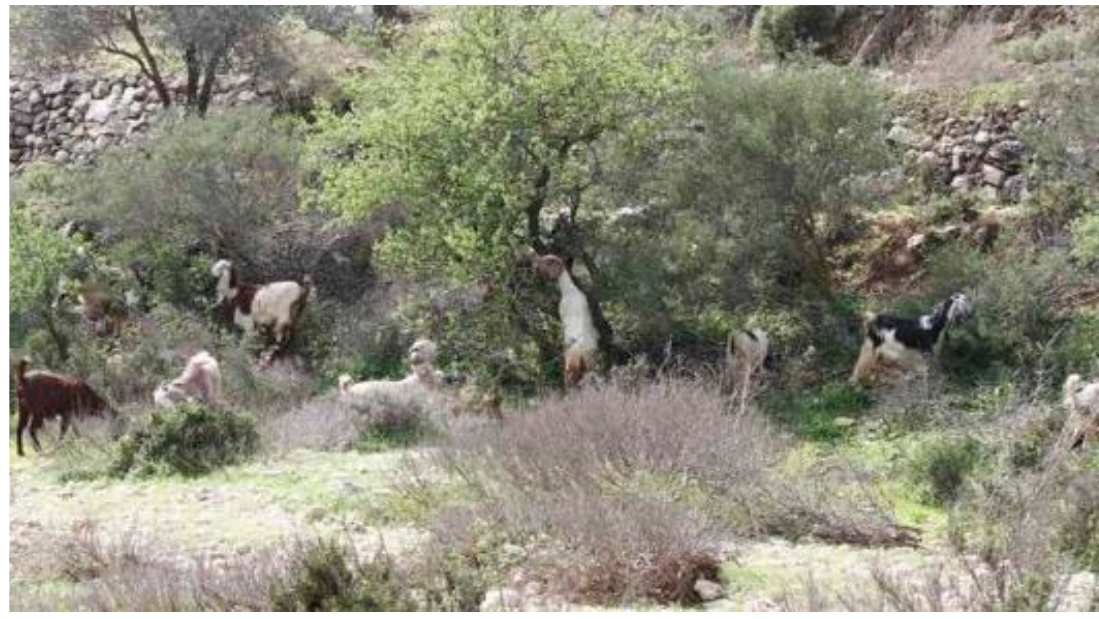
Figure 7. Overgrazing goats in Wadi Al-Zarqa.